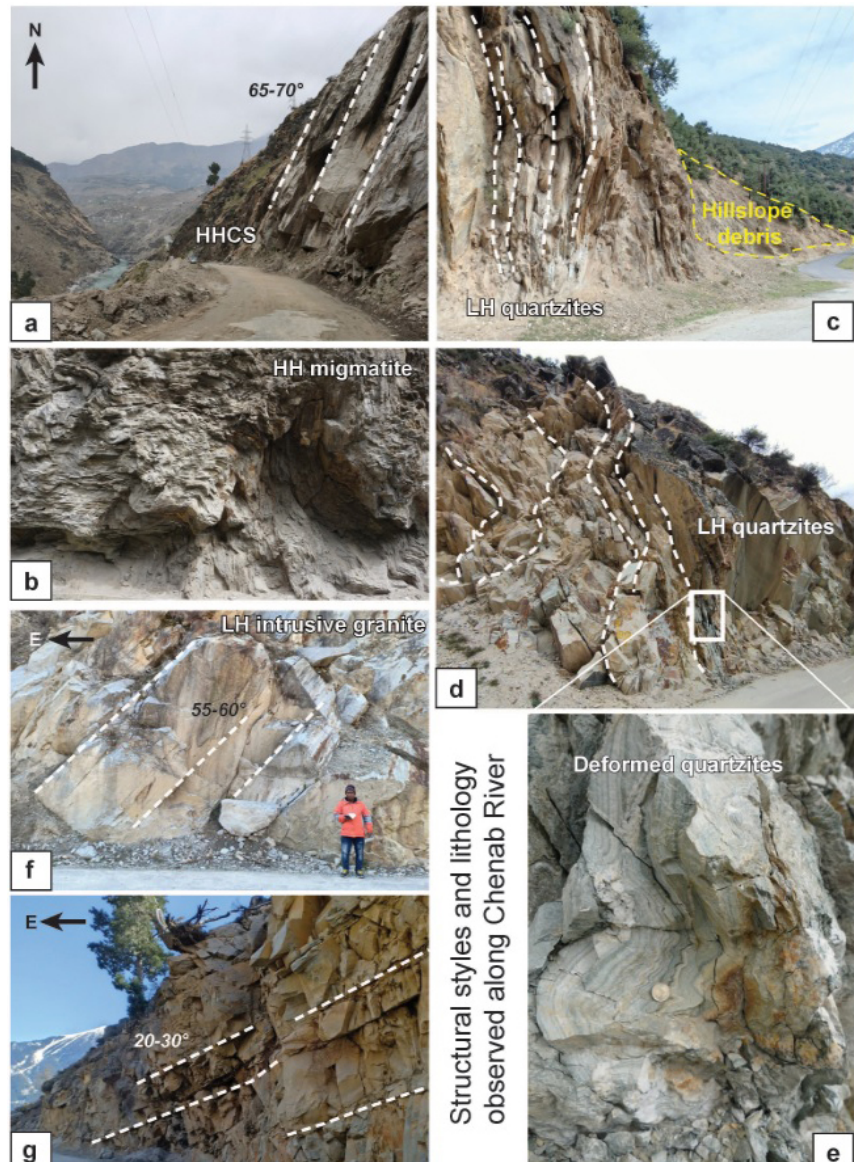
Figure 2. Lithological units and structural orientations observed in the Chenab valley. (a) Steeply dipping HHCS units near the western margin of the KW. (b) Highly deformed migmatites at the base of the KT. (c) Sub-vertical quartzite slabs of Chail Formation exposed in the frontal horses of the LH duplex (or anticline). (d) Highly deformed, sub-vertical, and pervasively folded and compressed quartzite layers within the core of the KW, with the base of stacked LH nappes forming the hanging wall of the proposed surface-breaking fault (Fig. 8d). (e) A close-up view of the folded quartzite units. (f) Steeply dipping units of granite, which formed new penetrative foliation outcropping upstream from the fault zone. (g) Further upstream from the fault zone, the bedrocks are gentler in the eastern edge of the